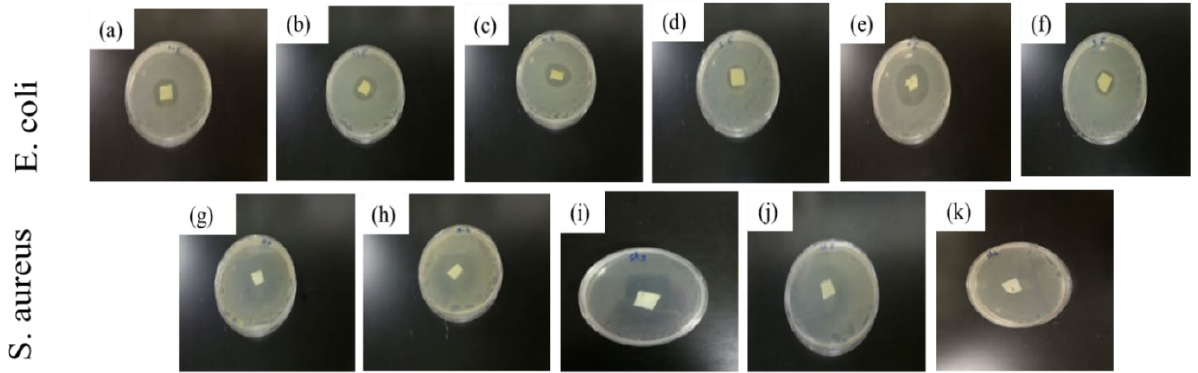
Figure 6. Inhabitation zones of porous PLA and porous PCL/PLA films soaked in cinnamaldehyde. ( a ) PL-N50 ( b )PL-N70 ( c ) PL-N100 ( d ) PL-PC4-N50 ( e ) PL-PC4-N70 ( f ) PL-PC4 N100 ( g ) PL-N50 ( h ) PL-N70 ( i ) PL-PC4-N50 ( j ) PL-PC4-N70 ( k ) PL-PC4 N100.